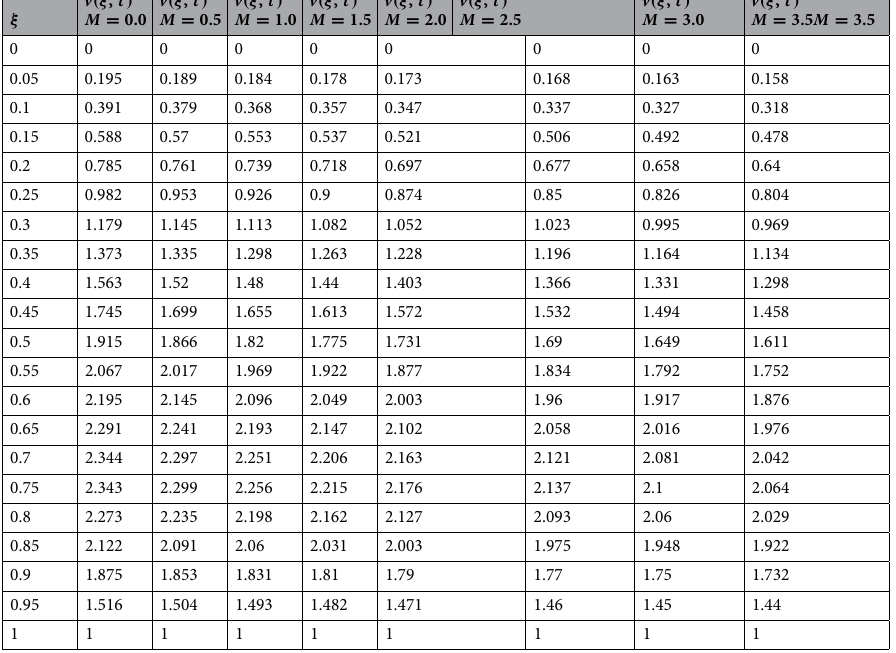
Table 4. For different values of Hartman’s number, the variations in velocity of hybrid nanofluids.